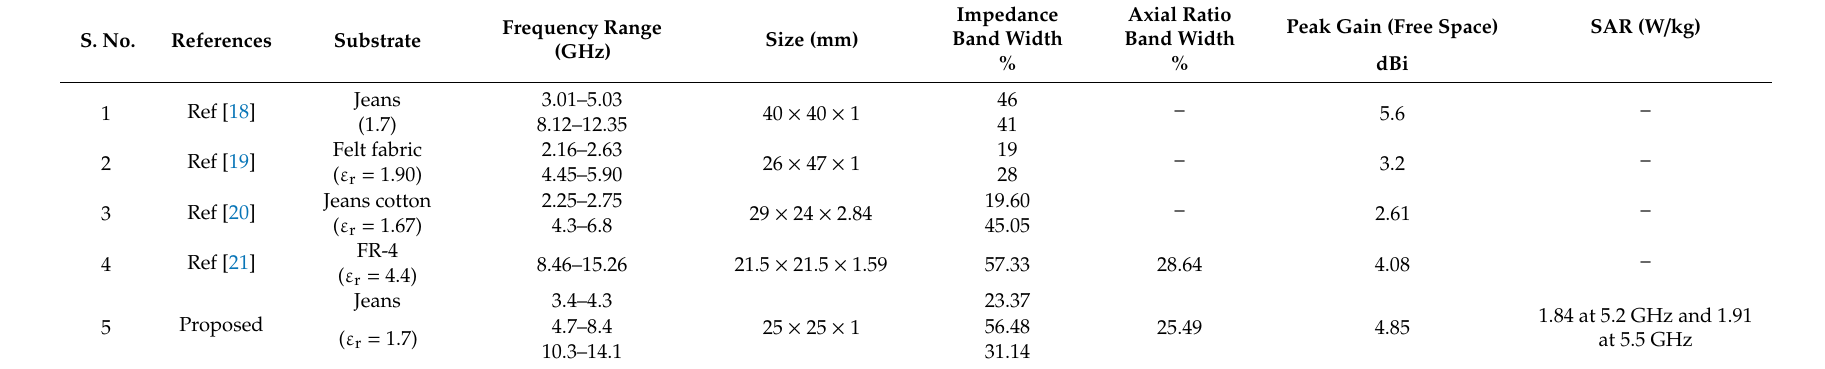
Table 5. Comparison of various existing antennas with anticipated